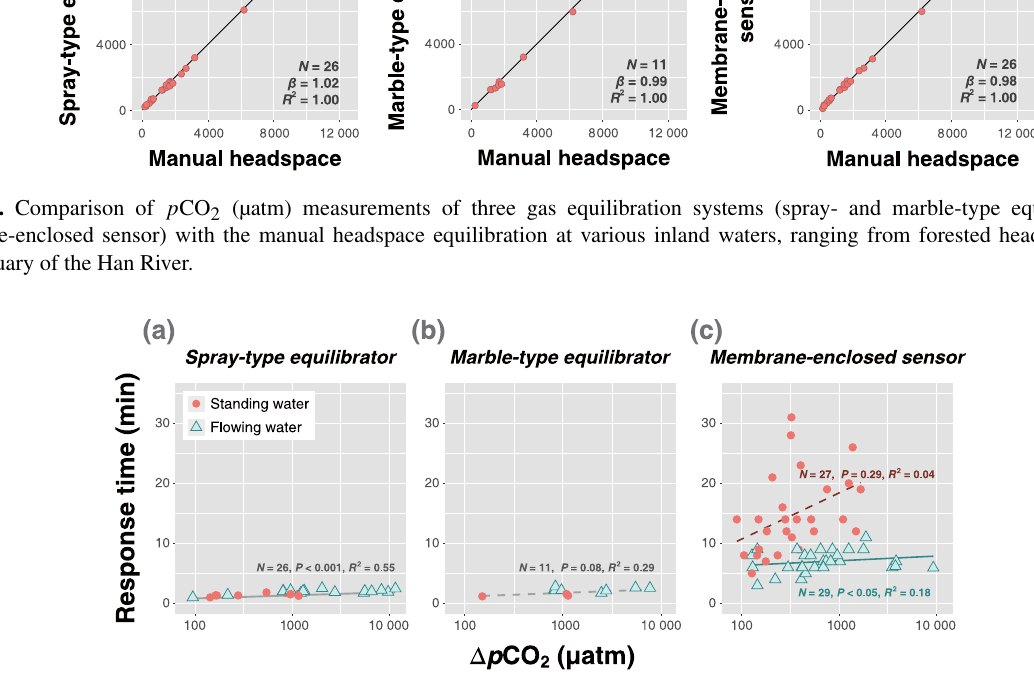
Figure 4. Relationship between the response time ( t 95 ) and (cid:49)p CO 2 , as the difference between the initial and the stabilized final p CO 2 measurement, for the (a) spray-type equilibrator, (b) marble-type equilibrator, and (c) membrane-enclosed sensor. Note that the x axis has a log scale. The solid and dashed lines indicate significant and insignificant relationships,